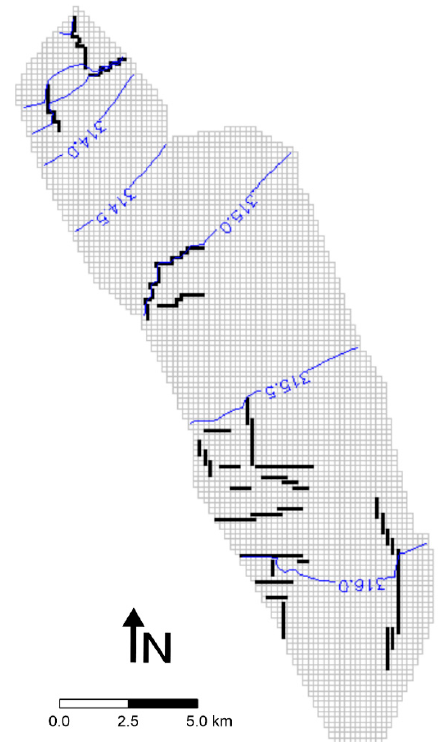
Figure 7. Output piezometric map for the steady state simulation. Table 2. Elements of the hydrogeological balance as calculated in the flow model.